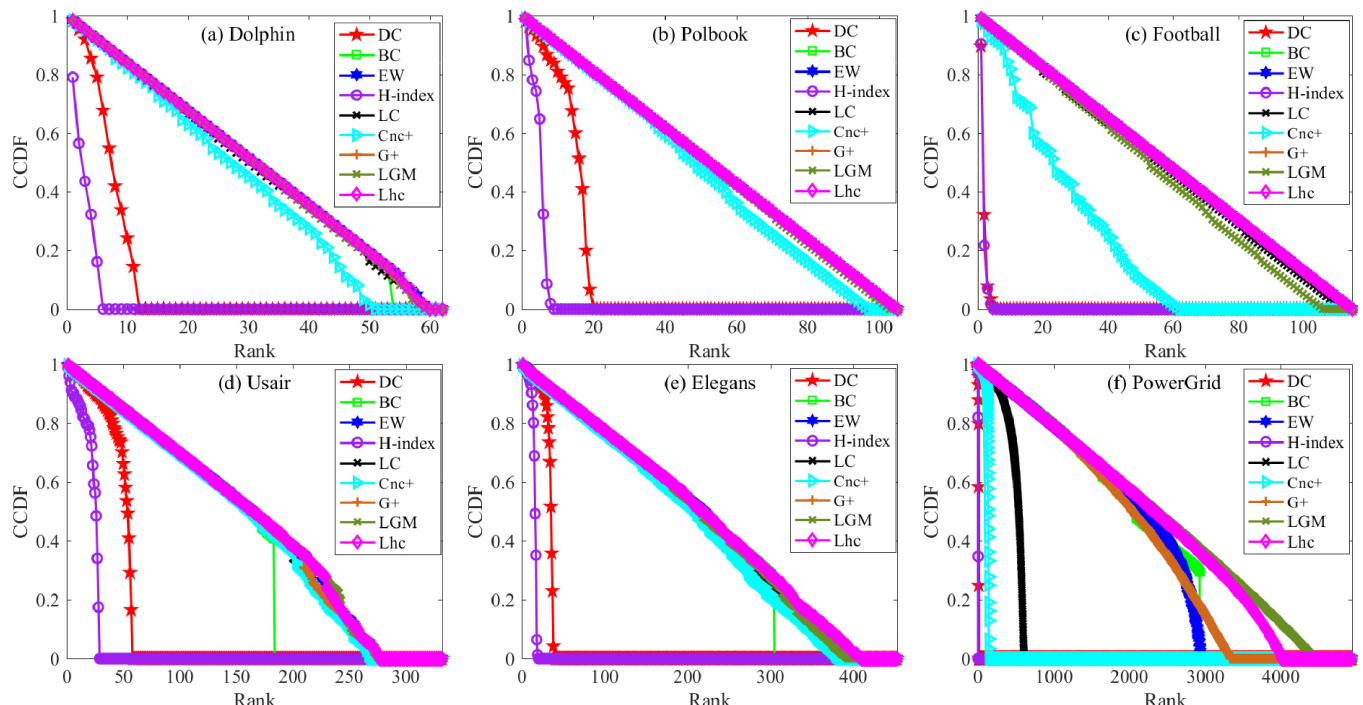
Fig 1. The Complementary Cumulative Distribution Function (CCDF) plot for ranking list offered by different measures. (a)-(d): The CCDF on the network of Dolphin, Polbook, Football, Usair, Elegans and PowerGrid respectively.